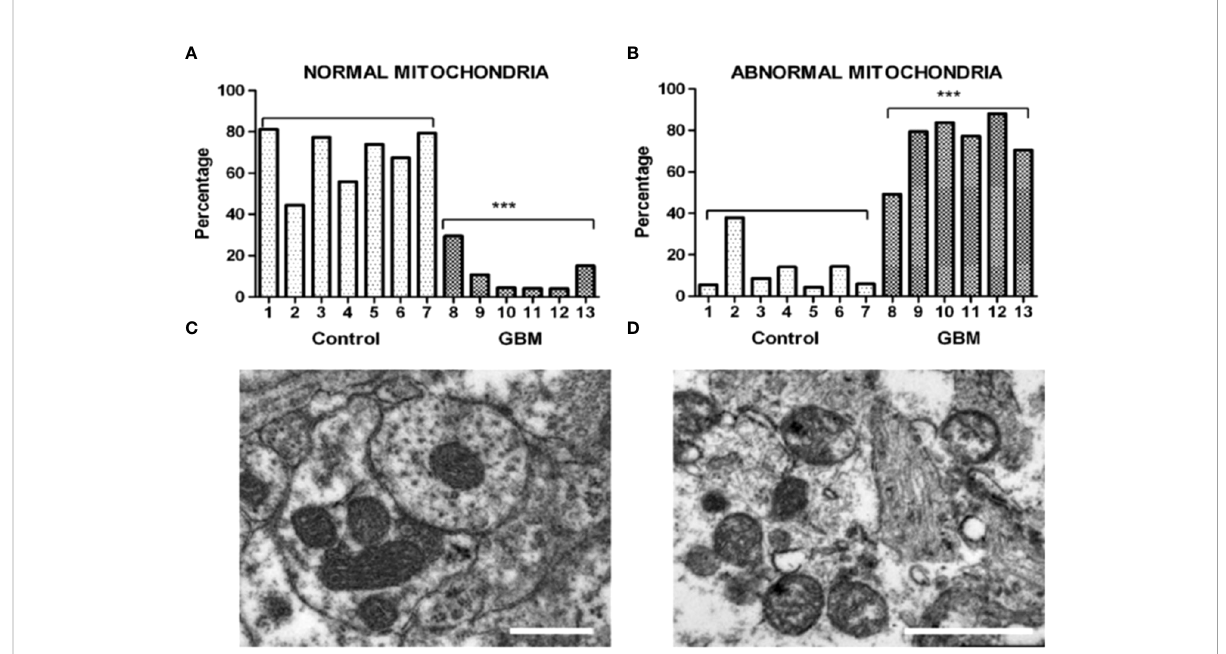
FIGURE 2 Morphological abnormalities seen in GBM mitochondria from the work of Deighton et al. (15). The morphology of 150 mitochondria was assessed in six GBM samples and in seven peri-tumoral control samples using Electron Microscopy (EM). (A) Percentage of normal mitochondria where cristae were visible throughout the mitochondria in peri-tumoral control and GBM samples (each bar represents one sample; *** p-value = 0.0001); (B) Percentage of abnormal mitochondria where cristae were sparse and abnormal in peri-tumoral control and GBM samples; *** p-value = 0.0001). (C, D) Representative EM images of normal and abnormal mitochondria, respectively. Cristolysis was signi fi cantly greater in mitochondria from GBM tissue than in mitochondria from normal surrounding brain tissue. The scale bars represent 0.5 um. The authors reported 117 mitochondrial proteins altered in GBM in association with ultrastructural mitochondrial abnormalities, similar to those described previously by Arismendi-Morillo et al. (16). ATP synthesis through OxPhos cannot be normal in tumor cells with these abnormalities. Image reproduced under a Creative Commons license from Deighton et al.